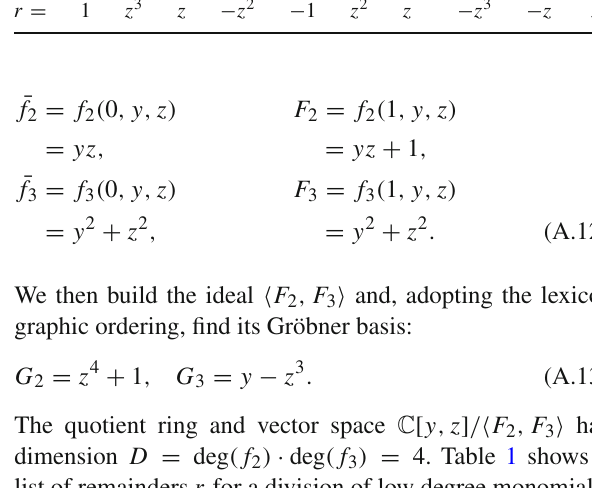
Table 1 Remainders r of a polynomial division of low degree mono- mials by the Gröbner basis G 2 , G 3